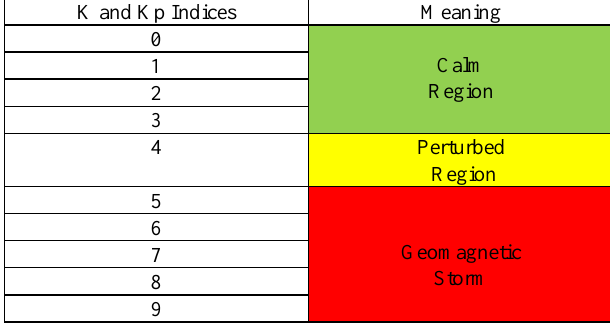
Table 2. Values of K&Kp indices and their meaning.